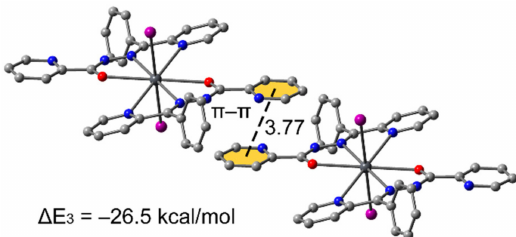
Figure 11. Theoretical models of the dimer of compound ( 2 ) (distance in Å). H-atoms omitted for